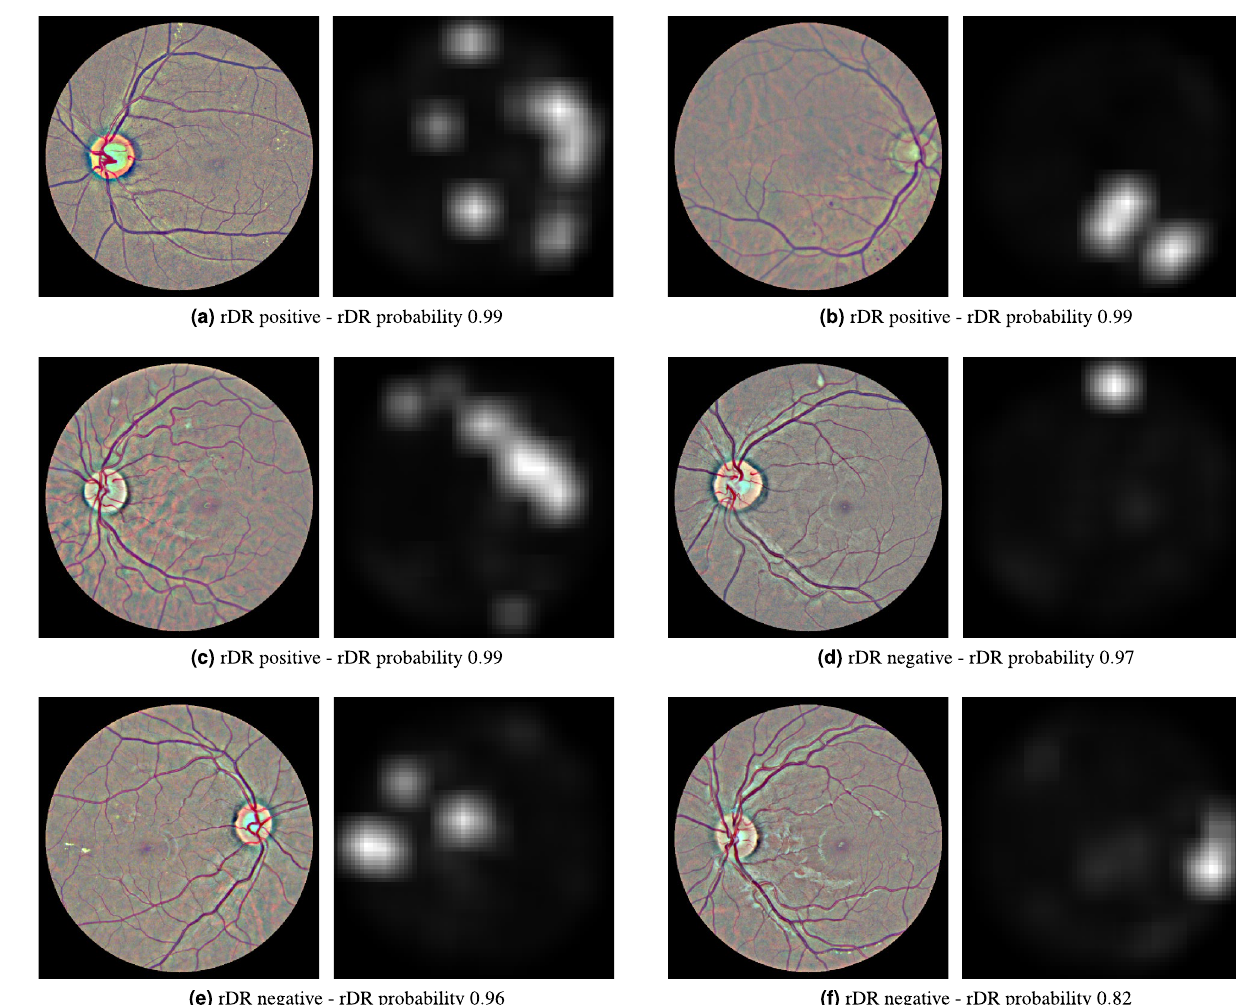
Figure 4. Examples of attention heatmaps produced by the model for 6 Messidor-2 images that corresponded to both true-positive and false-positive predictions.